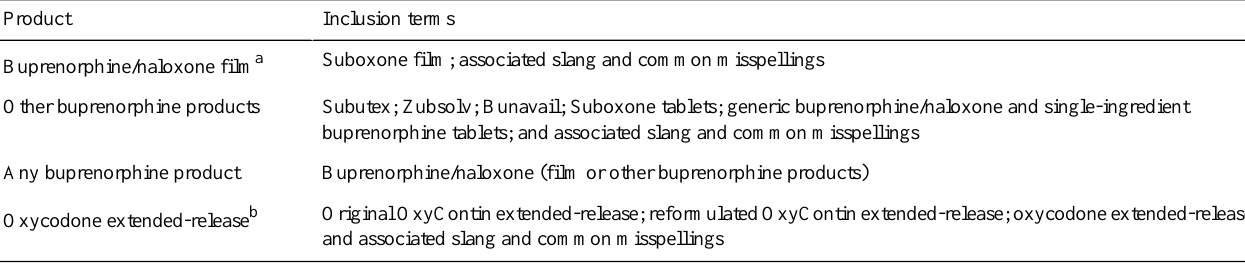
Table 1. Query inclusion terms.